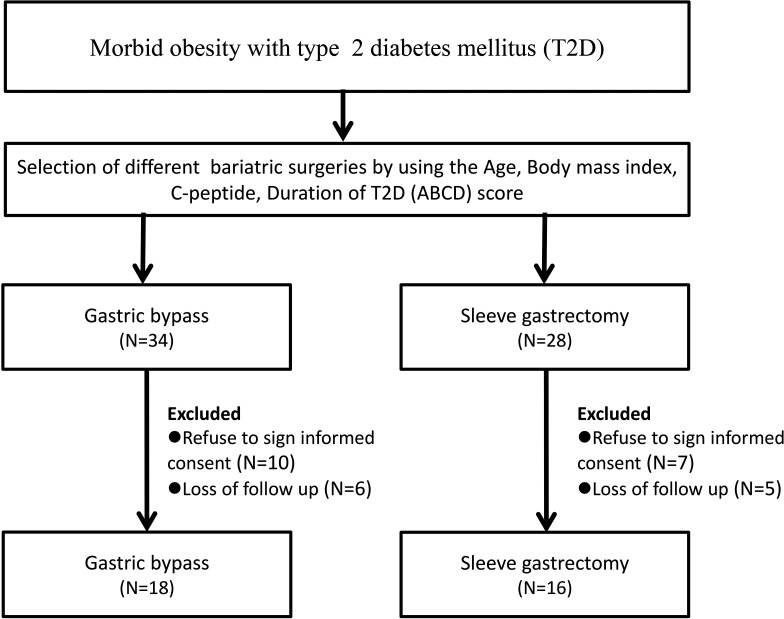
Flow chart of the patient selection process.